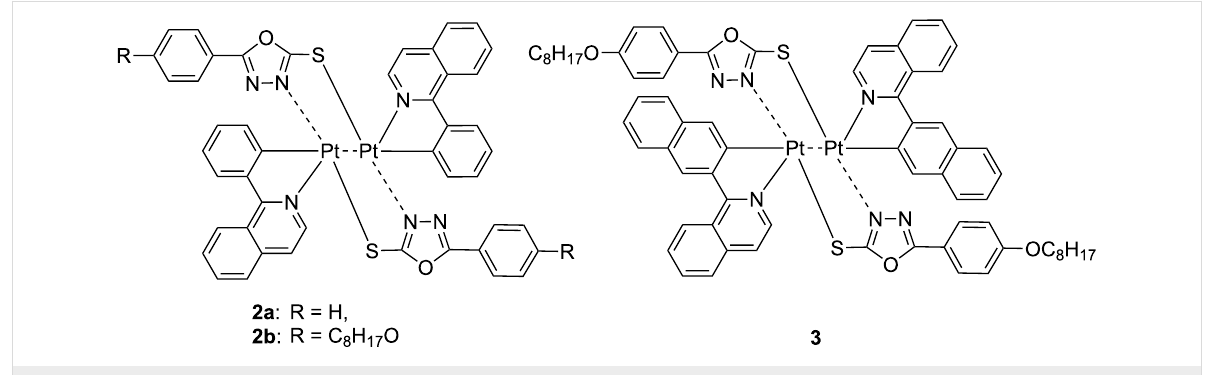
Figure 2: Chemical structure of the dinuclear Pt complexes 2a–b and 3 [20].